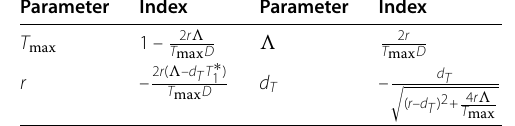
Table 3 Sensitivity indices for virus-free healthy T-cell population T ∗ Parameter Index Parameter